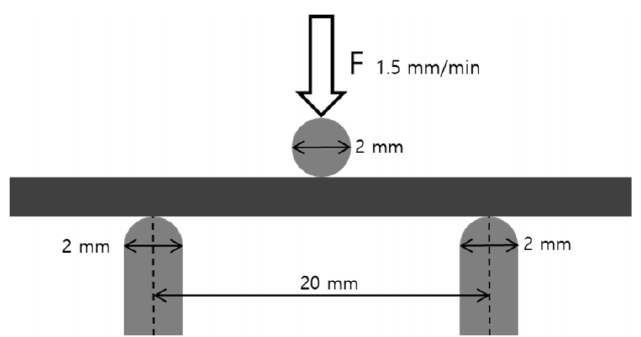
Figure 2. Schematic diagram illustrating the three-point bending test used to measure mechanical properties. The distance between the supports was 20 mm and the diameters of the bending piston and supports were each 2 mm. The bending piston was placed at the center and the crosshead speed of the loading part was 1.5 mm / min.